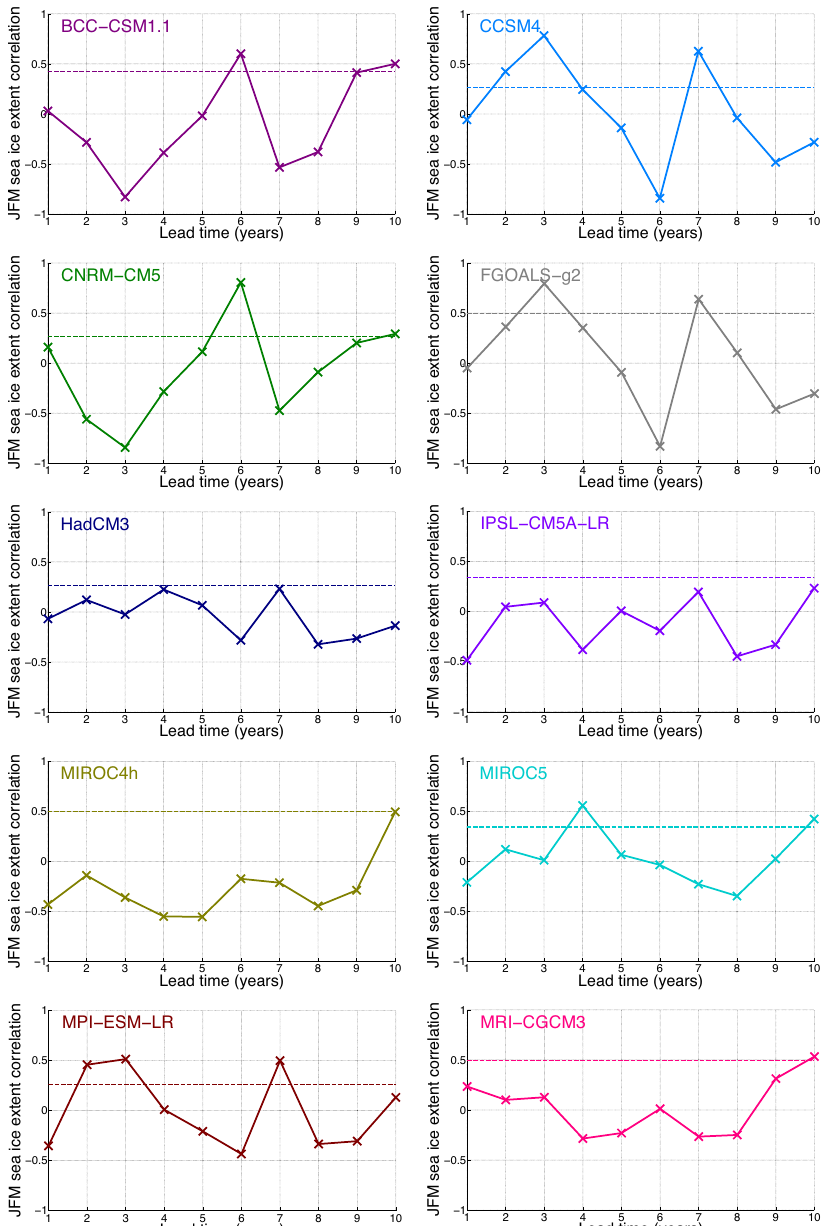
Fig. 6. Correlation between Southern Ocean summer (JFM) sea ice extent in model results and observations. For each model the correlation is computed from a series of 4 hindcasts ensembles, initialized every 5yr between January 1981 and January 1996 (between November 1980 and November 1995 for HadCM3). In each plot the dashed line refers to the 95% significance